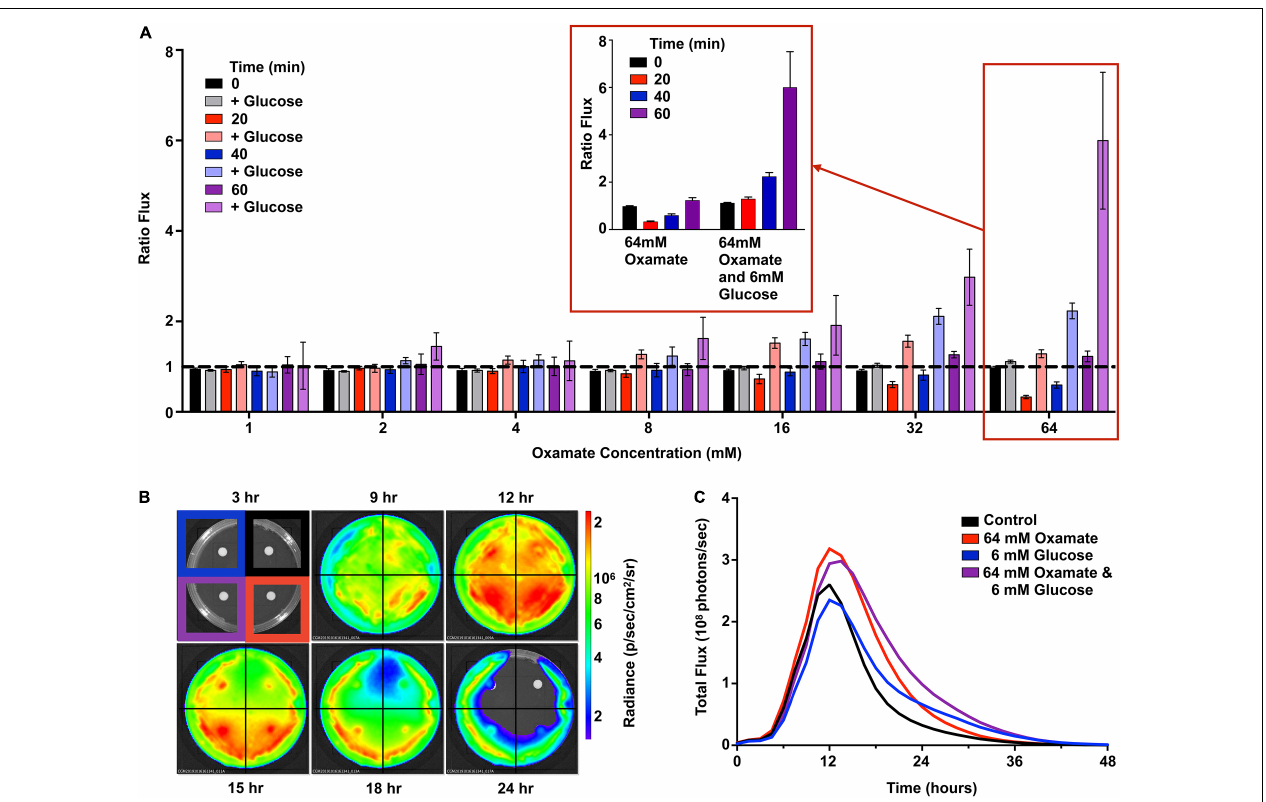
FIGURE 6 | Oxamate inhibition partially recovers the bioluminescent signal. (A) Strep . Xen20 in the stationary phase were combined with PBS alone (i.e., control) or PBS with concentrations of 6 mM glucose and 0–64 mM oxamate. Represented is the flux from cells treated with oxamate divided by the flux from cells in PBS alone (ratio flux). The data represent seven trials without or without glucose at the indicated times. Expansion of the 64 mM oxamate concentration with and without glucose over 60 min shown (denoted in red inset). (B) Strep . Xen20 was grown on LB agar with disks containing either a water control (upper right), 64 mM oxamate (lower right), 6 mM glucose (upper left), or both glucose and oxamate (lower left) monitored for 48 h. (C) Quantification of the luminescent signal from panel (B) as the total rate of photons generates (total